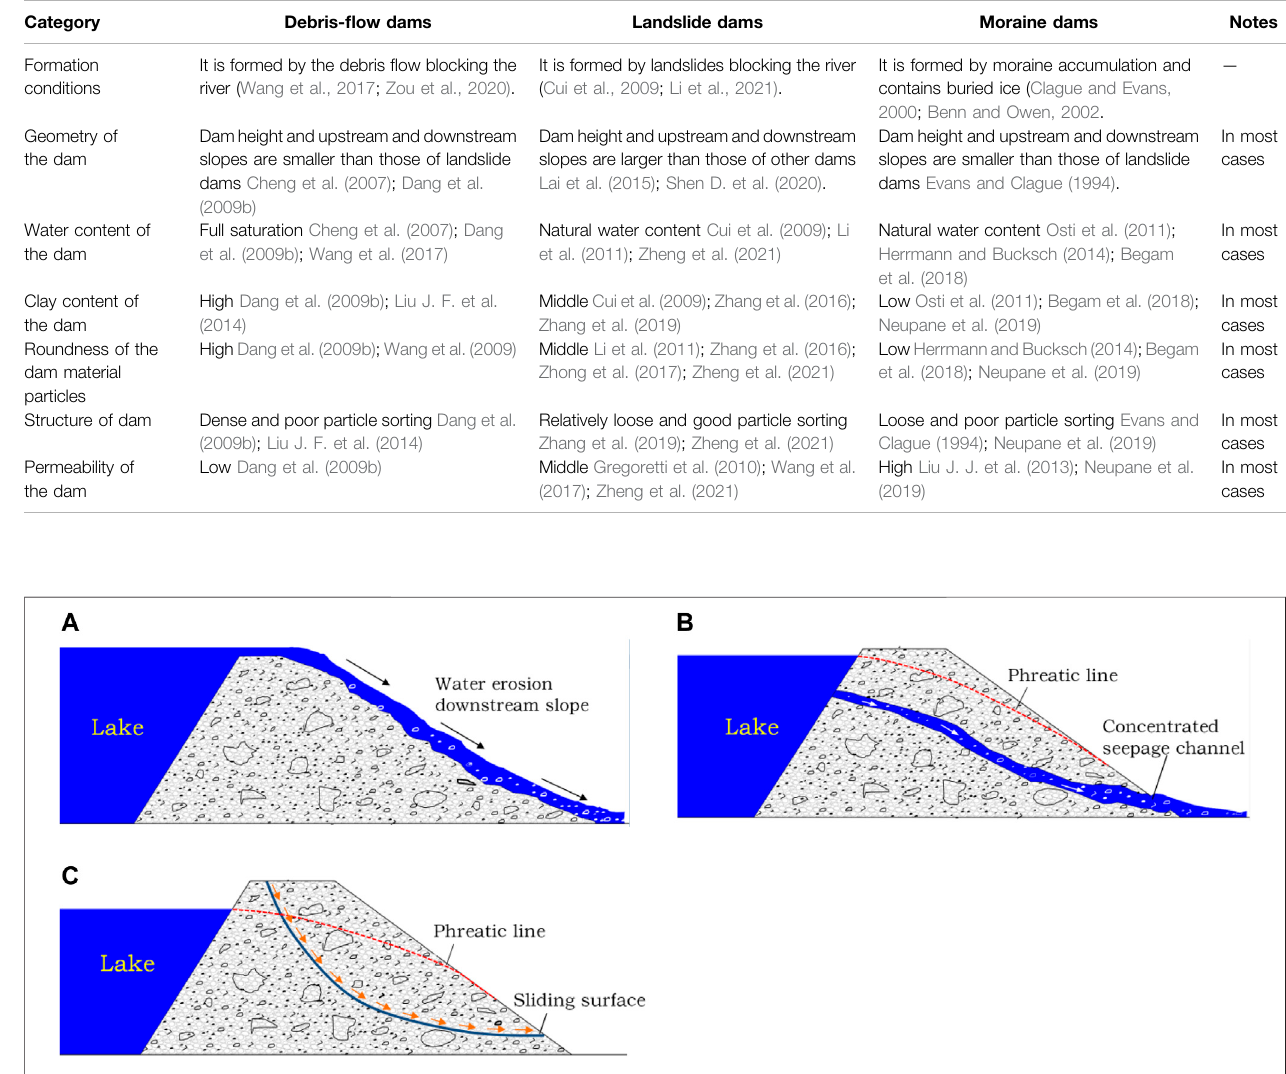
FIGURE 5 | Failure modes of a debris- fl ow dam: (A) Overtopping, (B) piping, and (C) slope instability.